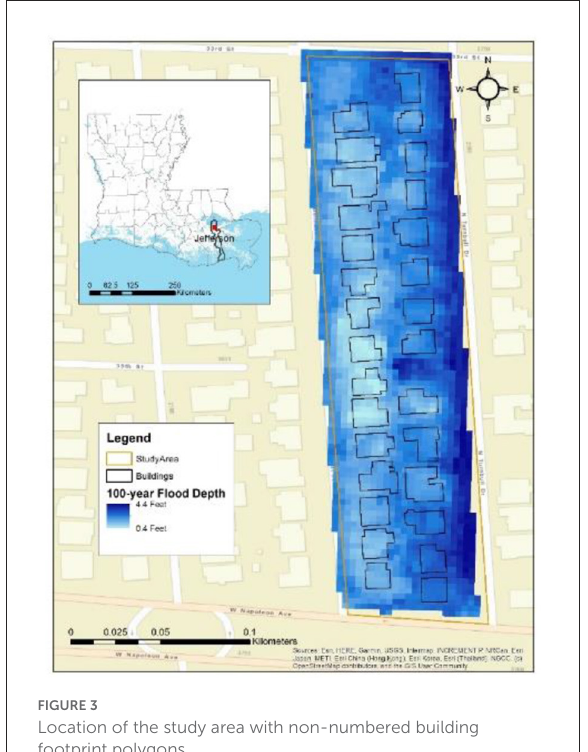
FIGURE3 Location of the study area with non-numbered building footprint polygons.